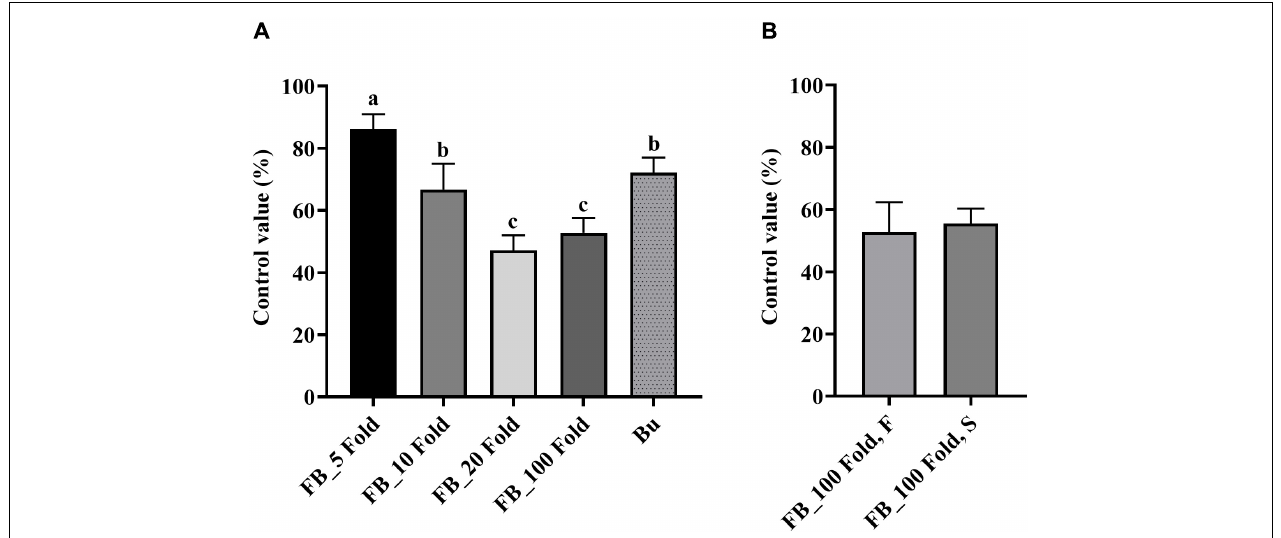
FIGURE 4 | Control efficacy of the fermentation broth of Streptomyces sp. JCK-6131 against tomato bacterial wilt in a pot experiment. (A) Treatment by soil drenching 1 day before inoculation. FB = fermentation broth of Streptomyces sp. JCK-6131, Bu = buramycin ( × 1000); analyzed by Fisher’s least significant difference test. (B) Treatment by foliar spraying (F) and soil drenching (S) 3 days before inoculation; analyzed by student t -test. Values are presented as the mean ± standard error of three runs, with three replicates each. The bars with the same letters represent non-significant differences between the treatments ( p <